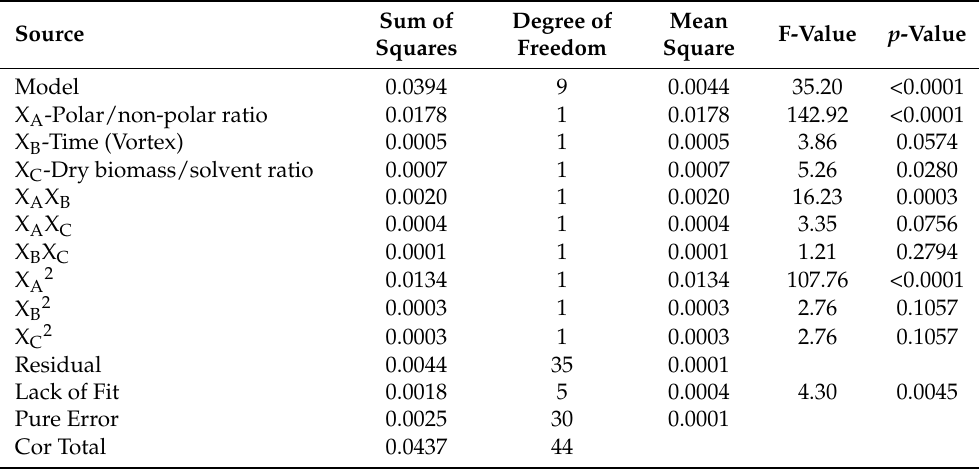
Table 4. ANOVA results for the applied FCC experimental design of lipid extraction using MeOH/Hex